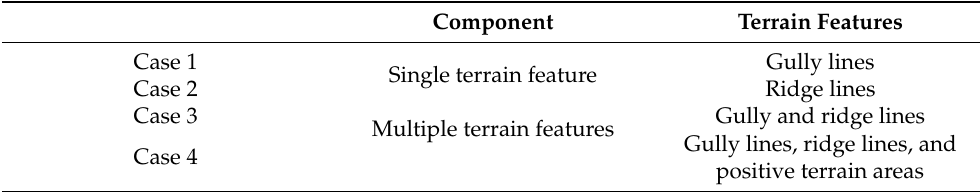
Table 1. Combinations of different terrain features.